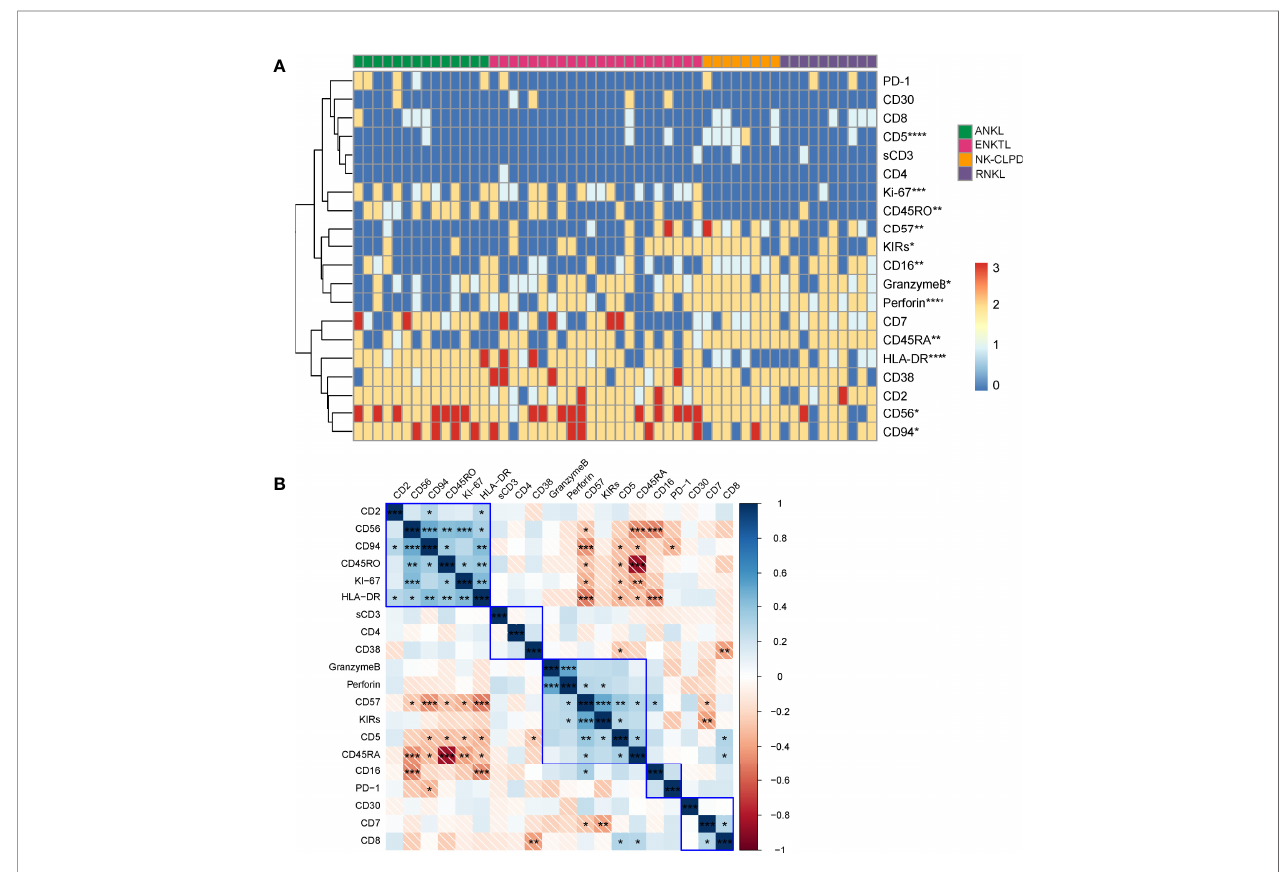
FIGURE 3 | Phenotype-based cluster analysis of ANKL, ENKTL, NK-CLPD and RNKL. (A) Clustering of 20 immunomarkers of NK cells from patients with ANKL (n = 14), ENKTL (n = 23), NK-CLPD (n = 8) and RNKL (n = 10) Graph. The horizontal axis is for each individual patient and the vertical axis is for the immune markers. (B) Correlation matrix of the 20 immunomarkers. (*p < 0.05, **p < 0.01, ***p < 0.001, ****p <